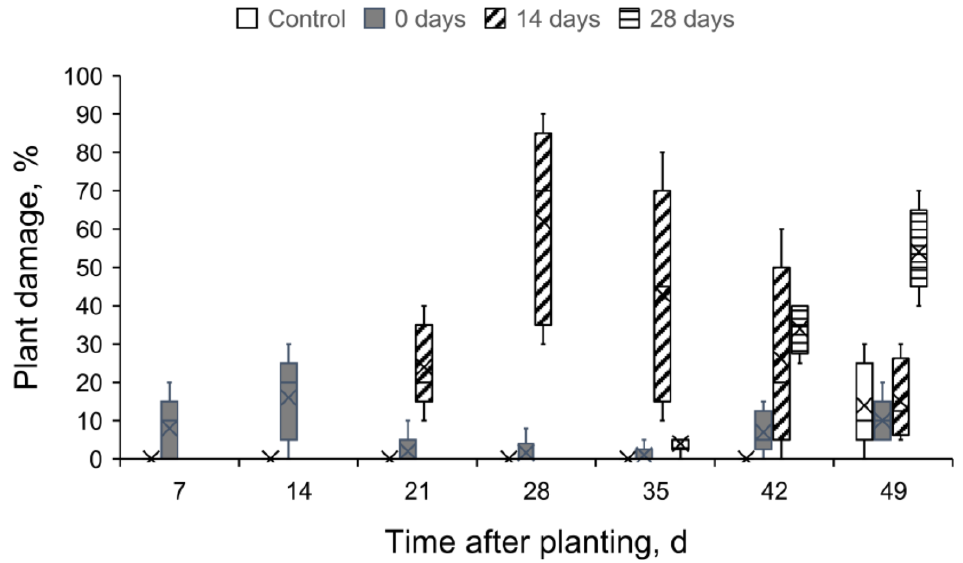
Figure 1. Damage in potatoes treated with S. alba extract at the time planting (0 days), 14 and 28 days after planting. Plant damage was calculated as a percentage of discoloured leaf area relative to the total area.